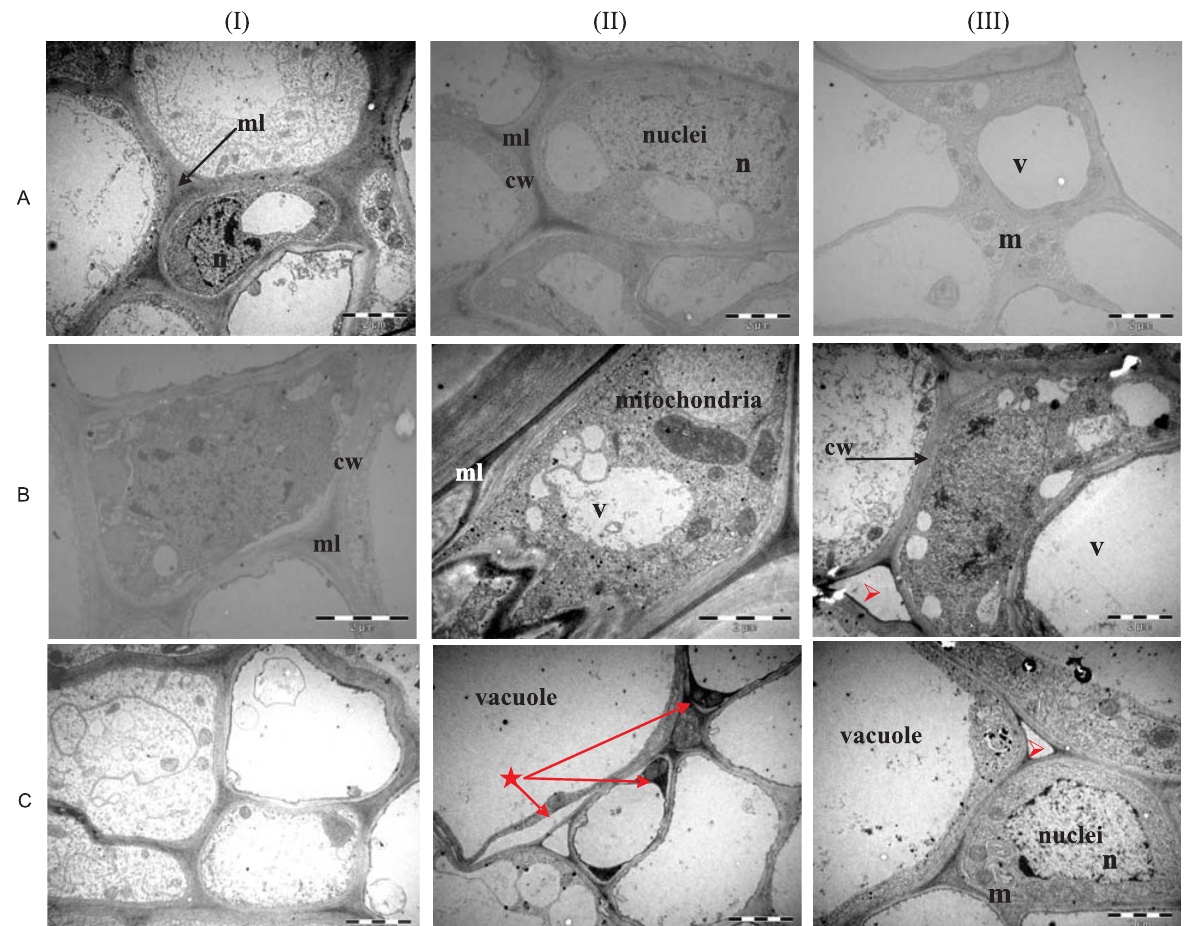
Figure 2. Transmission electron micrographs (x 3.000) showing root cell structure of soybean cultivars Santa Rosa (I), IAC-15 (II) and IAC-Foscarin 31 (III), as related to Mn rates of 0.5 μμμμμ mol L -1 – deficiency (A), 2.0 μμμμμ mol L -1 – control (B) and 200.0 μμμμμ mol L -1 – toxicity (C) in the nutrient solution. Abbreviations for all parts in alphabetical order: cw, cell wall; ml, middle lamella; m, mitochondria; n, nuclei; v, vacuole. [ ] Detail of separated protoplast from cell wall in cultivar IAC-15, under Mn excess in the solution, and the apoplast (or apparent free space) [ ] in IAC-Foscarin 31, as related to Mn rates